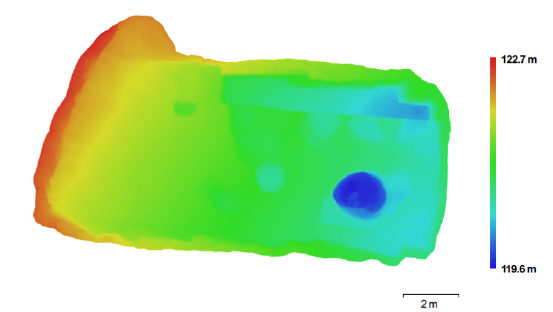
Figure 9: Reconstructed Digital Elevation Model